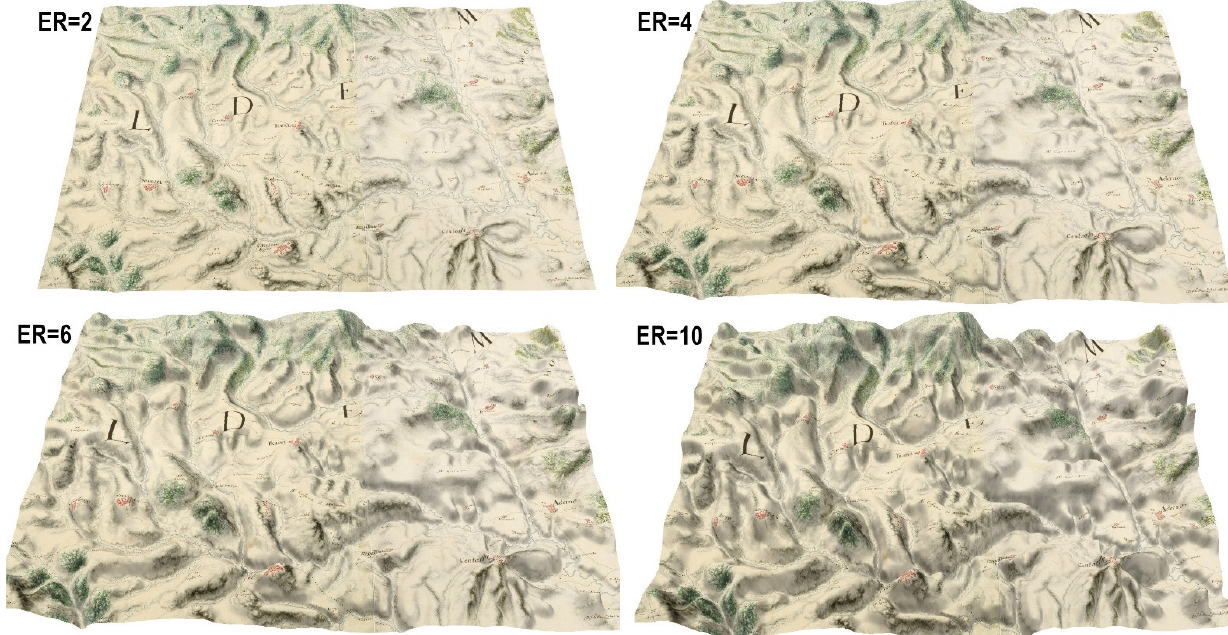
Figure 5. Four values for vertical scaling factor (elevation rise): 2, 4, 6, and 10.